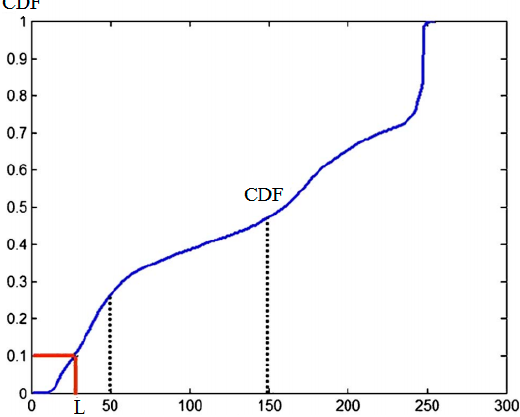
Figure 2. Cumulative distribution function of the gray value: The red line is the cumulative probability; blue line is the CDF curve; gray line is the brightness value.